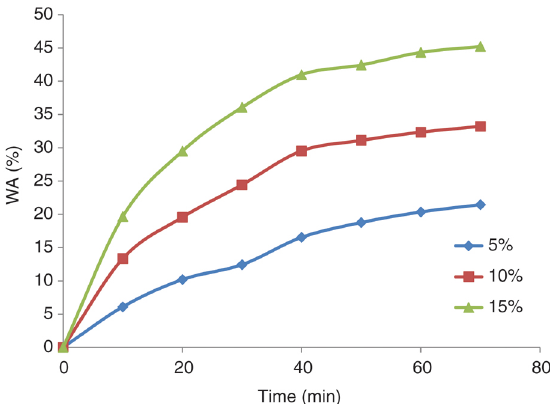
Figure 13: WA for samples with epoxy